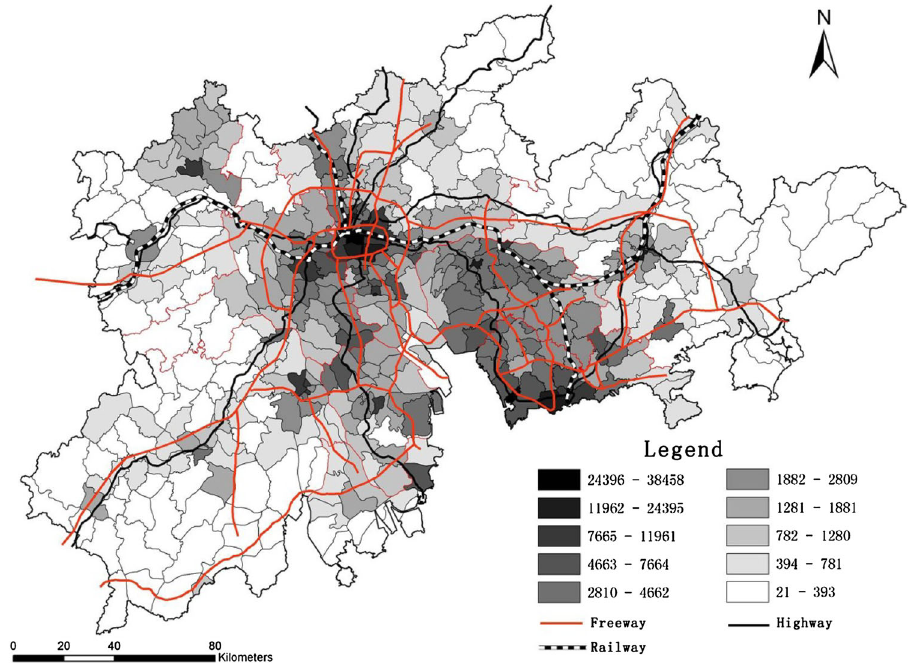
Fig. 1 Overlapped population density and